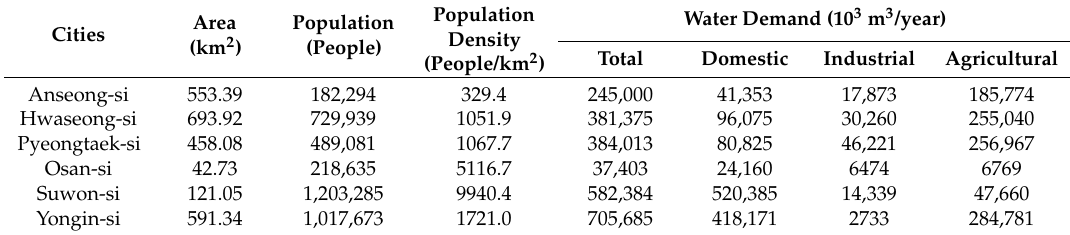
Figure 1. Water supply areas and location of water purification plant. Table 1. Area, population, and water demand of study area.